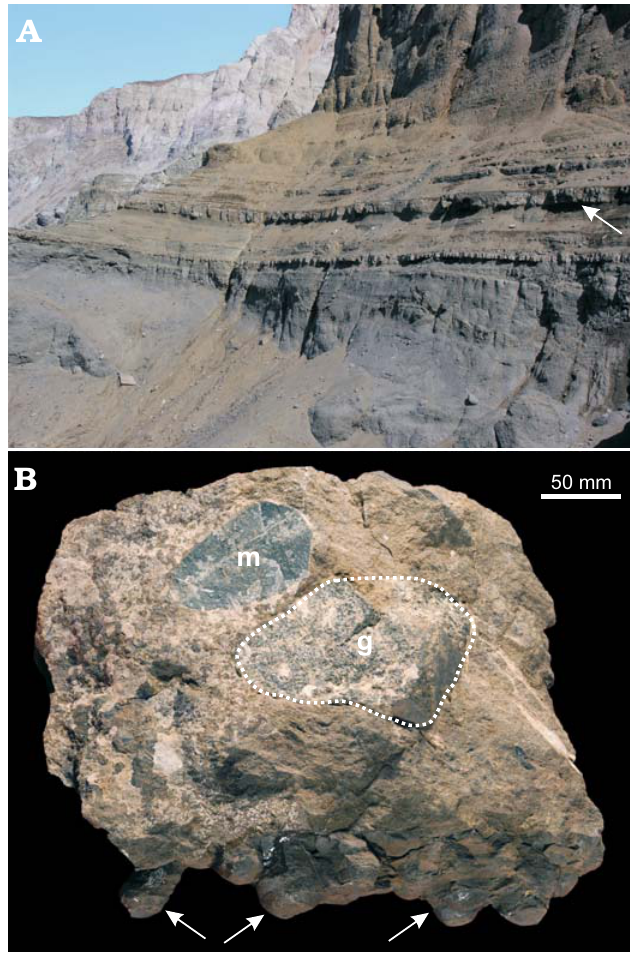
Fig. 3. A . Outcrops of glaciomarine strata of the Oligocene Polonez Cove Formation (the Siklawa Member) on King George Island, arrow indicates position on Pholadidea gradzinskii horizons at Mazurek Point (photograph by AG, January 2007). B . Diamictite from bed in Siklawa Member of the Polonez Cove Formation, with Pholadidea gradzinskii bearing moulds at the base (arrowed). The diamictite contains metamorphic (m) and granitoid (g)